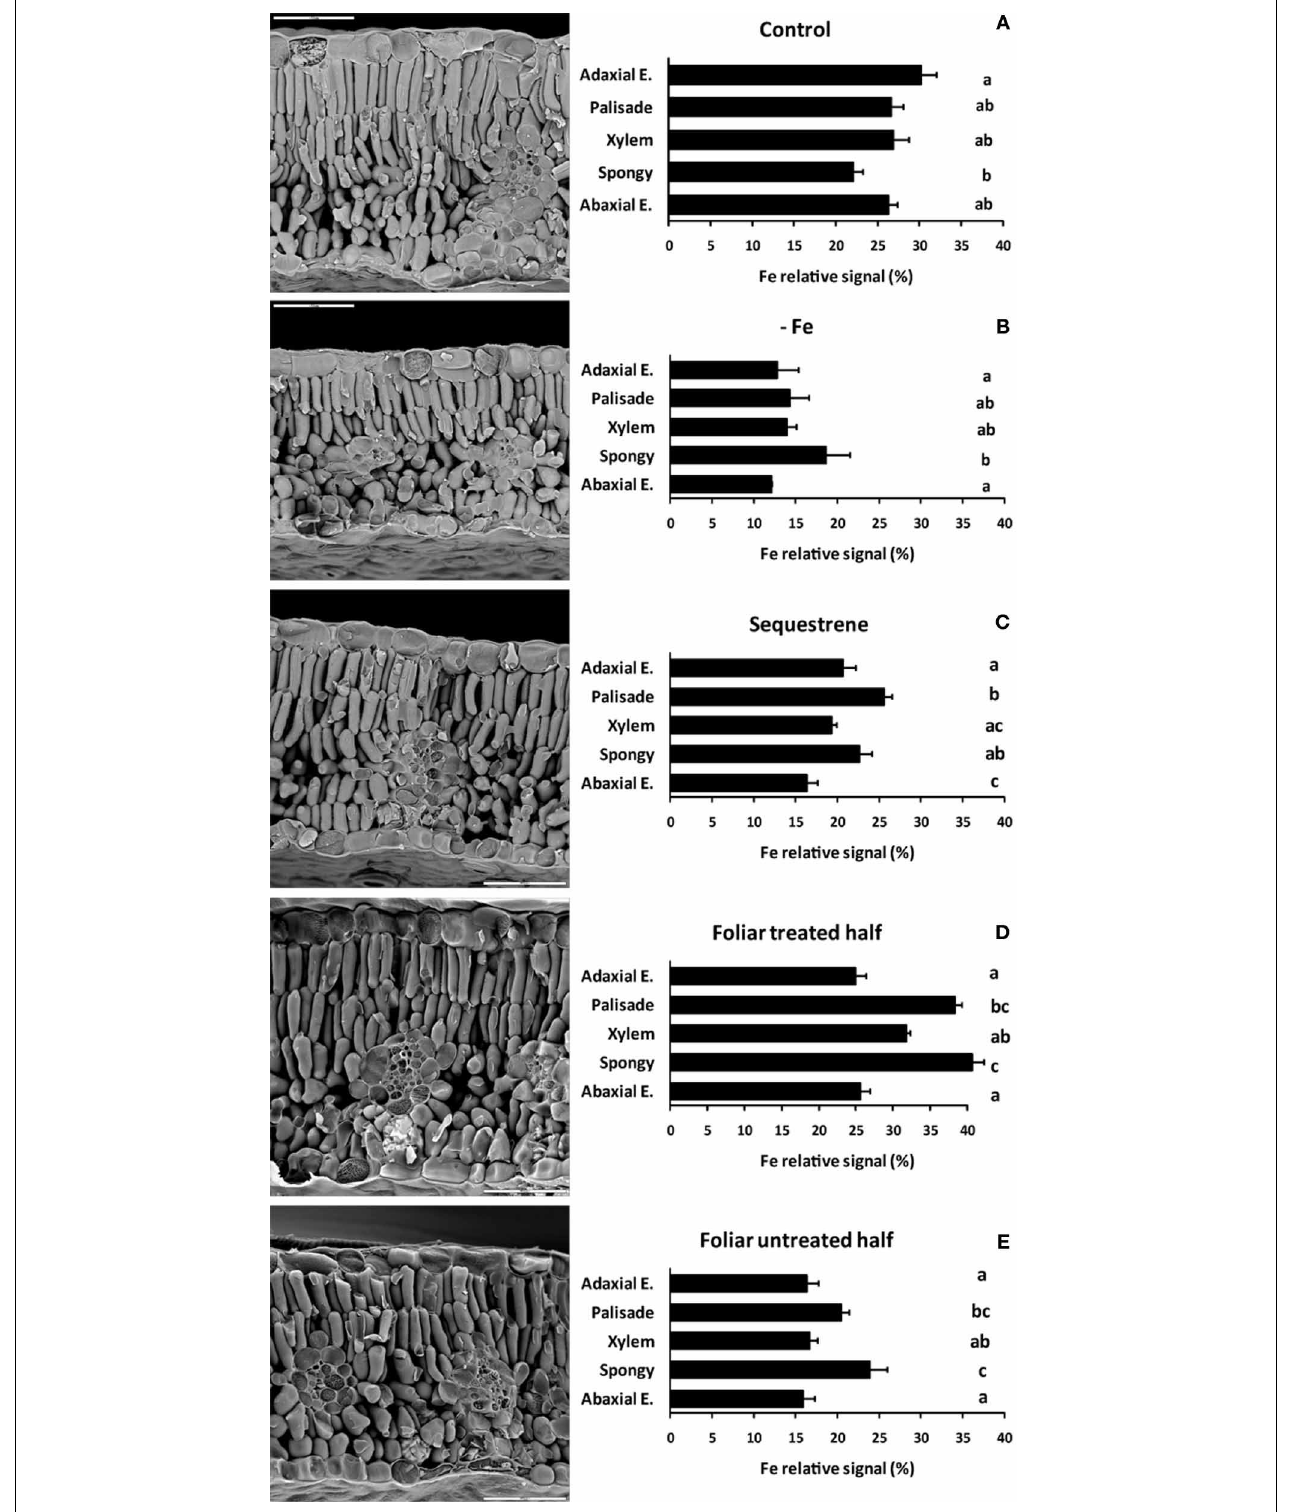
FIGURE 6 | LT-SEM micrographs (left panels) and semi-quantitative EDX analysis (spot mode, right panels) of transversal sections obtained by cryo-fracture from peach tree leaves. (A) Fe-sufficient control; (B) Fe-deficient chlorotic; (C) soil Fe-fertilized (Fe(III)-EDDHA –Sequestrene-, 50 g